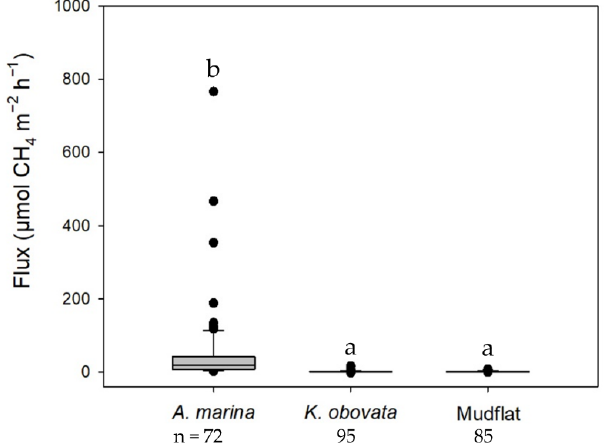
Figure 4. CH 4 emissions from the A. marina and K. obovata mangroves and the adjoining mudflats soils. Different letters represent significant differences among habitats with the Kruskal–Wallis test and Dunn's test. Table 2. CH 4 emissions and soil characteristics (mean ± standard error) of the mangroves at A — Wazihwei (WZ); B — Zhuwei (ZW); C — Xinfeng (XF); D — Zhunan (ZN); E1 — Fangyuan Kandelia obovata (FY-K); E2 — Fangyuan Avicennia marina (FY-A); F — Budai (BD); G — Beimen (BM); H — Chiku (CK) . Different letters represent significant site differences according to the Kruskal –Wallis test and Dunn’s test at the significance level. ORP — redox potential. Mangrov e Site